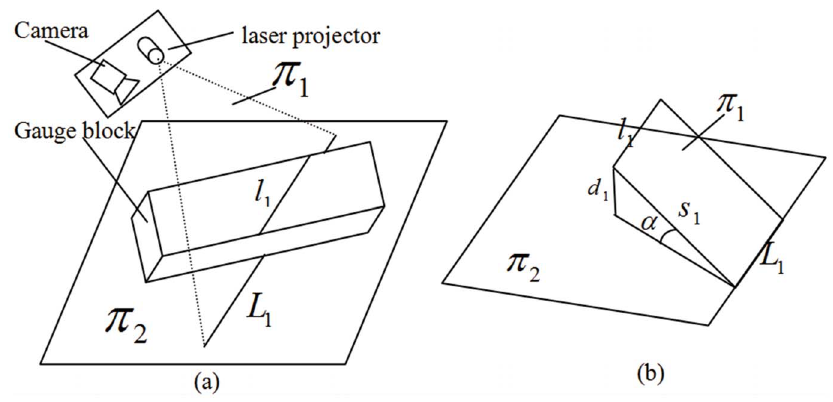
Figure 14. The schematic diagram of measurement.